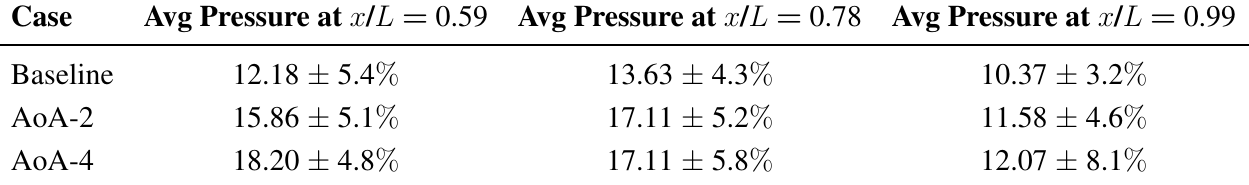
Table 1. Average spanwise static pressure and its standard deviation as an indicator of spanwise